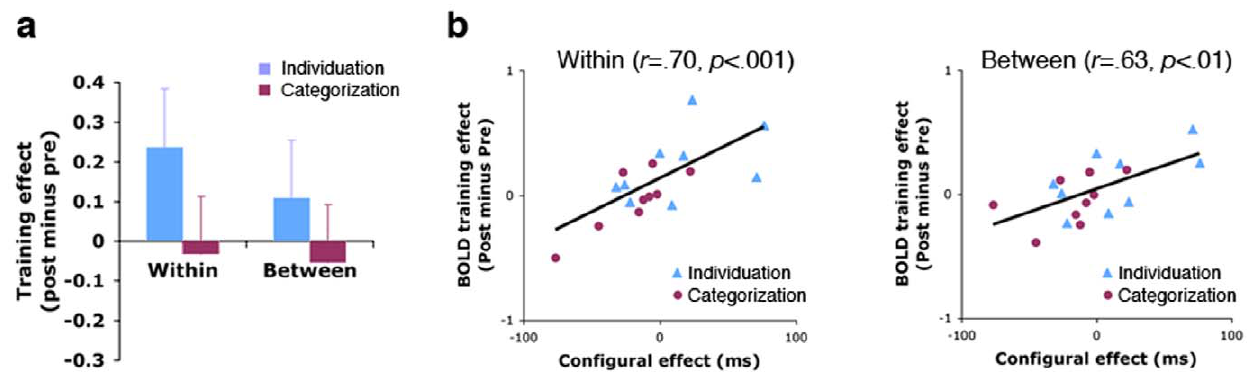
Figure 3. Training effects in the group-defined face-selective, right fusiform region (Talairach coordinates: 40, 2 44, 2 18). (a). Activity changes (post minus pre) for Ziggerins during within- and between-class discrimination after individuation vs. categorization training. Error bars represent the 95% confidence intervals for group differences. (b). Correlations between training-induced activity changes in this right fusiform region for the Ziggerins and the configural processing effect found for the Ziggerins measured behaviorally.